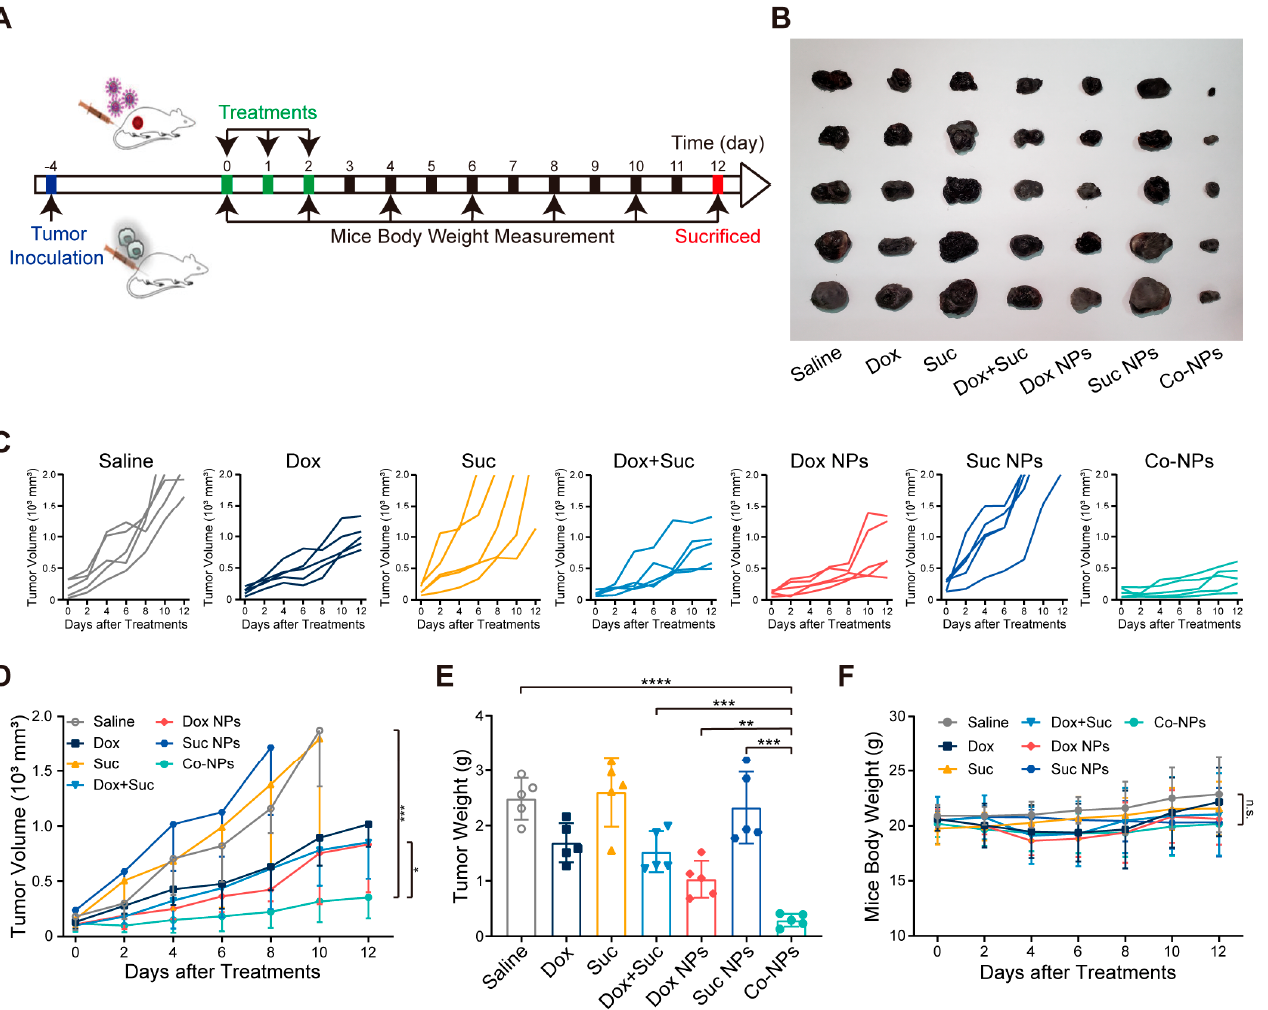
Figure 5. In vivo anti-primary tumor efficacy. ( A ) Workflow for the treatment of B16F10 melanoma tumor-bearing mice. On day 0 (defined as the 5th day after tumor inoculation), day 1, and day 2, mice were administrated with saline, Dox, Suc, Dox + Suc, Dox NPs, Suc NPs, and Co-NPs. Tumor volume and body weight of mice were monitored every 2 days from day 0 to day 12. ( B ) Photograph of tumors collected on day 12. ( C ) Time-dependent tumor growth curves of mice for individual groups during the treatments. ( D ) Time-dependent tumor growth curves of all groups during the treatments. ( E ) Tumor weight of mice for individual groups after different treatments. ( F ) Changes in body weight of mice during the treatment. (n.s., not significant, * p < 0.05, ** p < 0.01, *** p < 0.001, **** p < 0.0001).